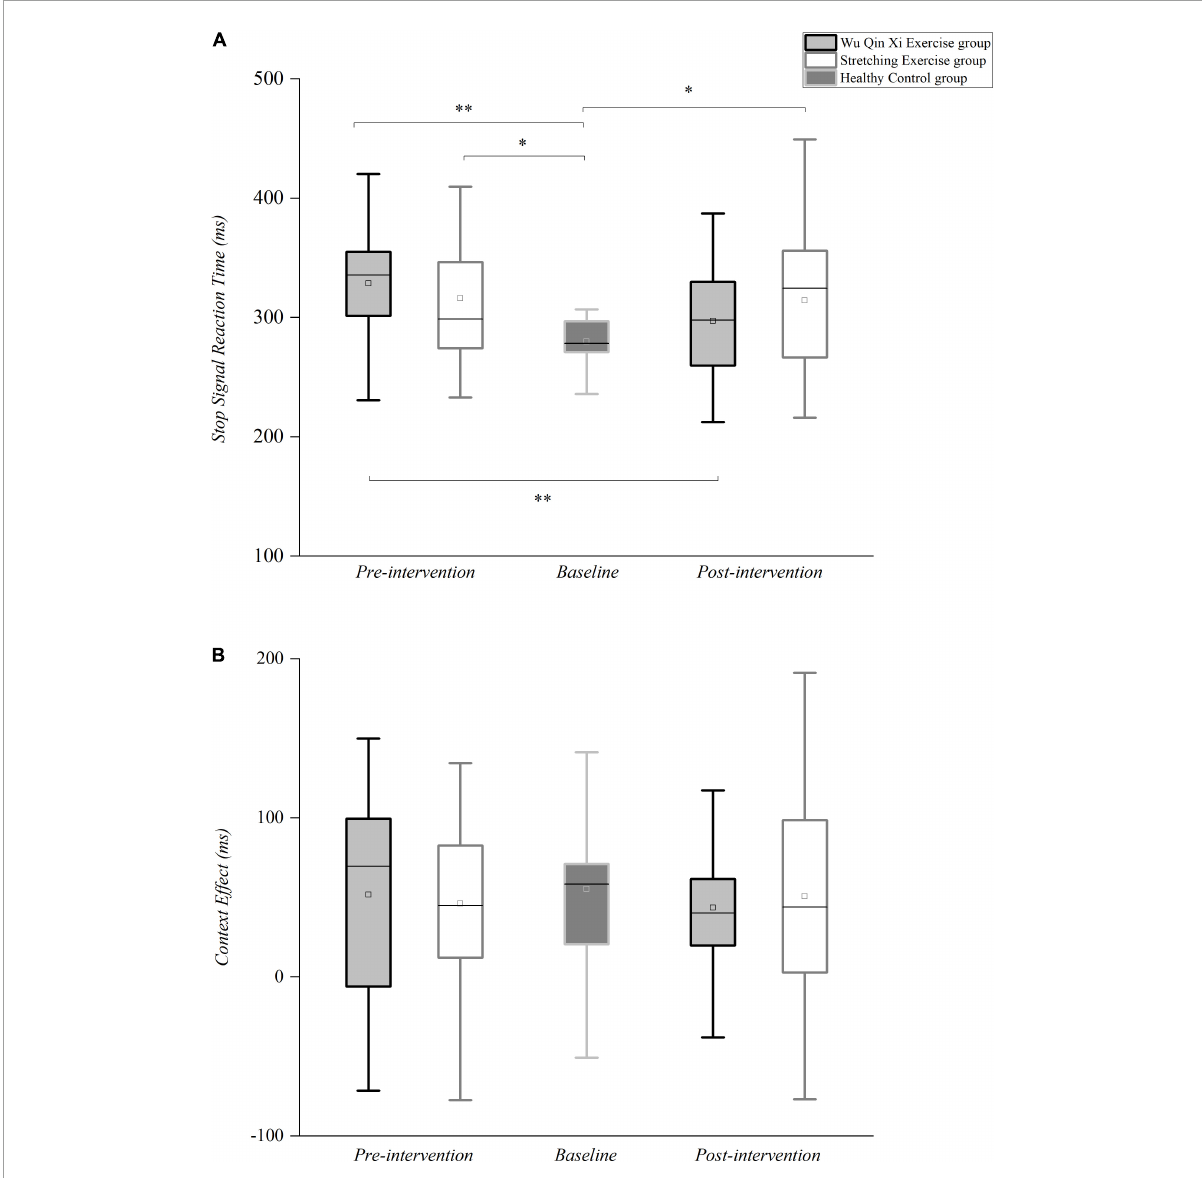
FIGURE4 Differences in reactive and proactive motor inhibition between the healthy control and PD groups pre- and post- intervention. (A) Reactive inhibition. Box plot of stop-signal reaction times. (B) Proactive inhibition. Average context effect values. In the box plots, thick black lines represent medians, box boundaries represent lower and upper quartiles, box centers are means, and whiskers represent values 1.5 times the interquartile range. ∗ p < 0.05, ∗∗ p <